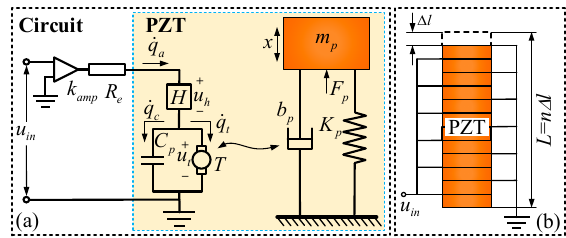
Figure 2. Schematic diagram of the piezoelectric actuator: ( a ) Electromechanical model of the piezoelectric actuator; ( b ) connection of the layers comprising the piezoelectric actuator.